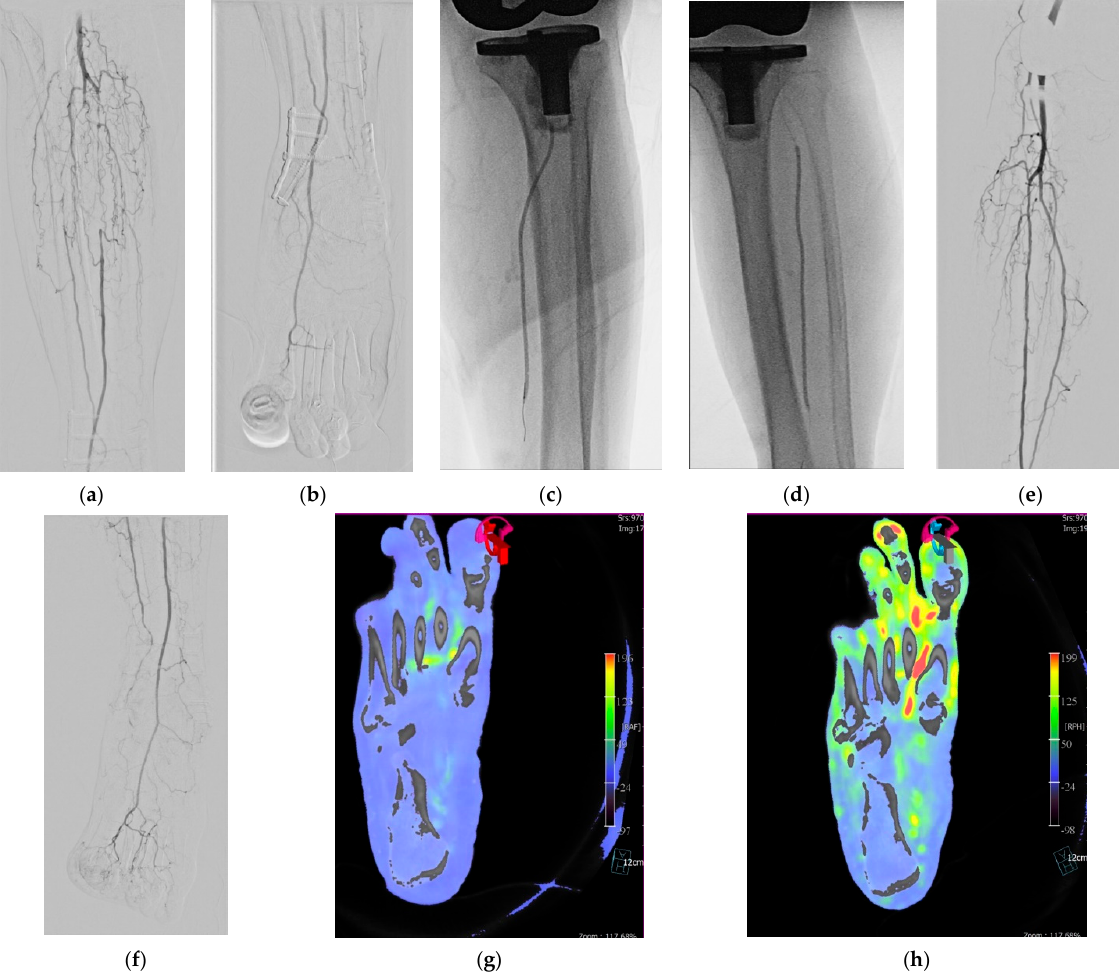
Figure 1. A 73-year-old woman with peripheral arterial disease underwent percutaneous transluminal angioplasty for the first and second toe wound. ( a , b ) Initial angiography shows long segmental occlusion of left anterior tibial artery (ATA) and posterior tibial artery (PTA) and total occlusion of left peroneal artery with decreased flow to the foot including first and second toe. ( c , d ) Recanalization with 0.014-inch guidewire and balloon angioplasty was done with a 2 mm–15 cm balloon catheter. ( e , f ) Completion angiography shows patent left ATA and PTA and increased flow to the foot especially first and second toe. ( g , h ) Cone-beam computed tomography-based foot perfusion mapping before ( g ) and after ( h ) angioplasty clearly shows markedly increased perfusion of the foot, especially first and second toe.